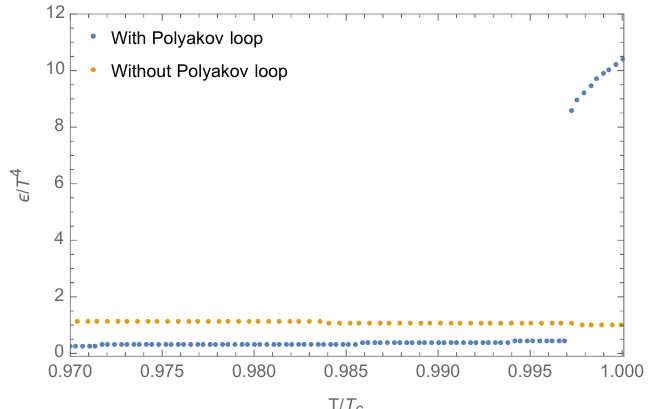
Figure 15 . The latent heat (3.78) normalized by T 4 as a function of T=T c